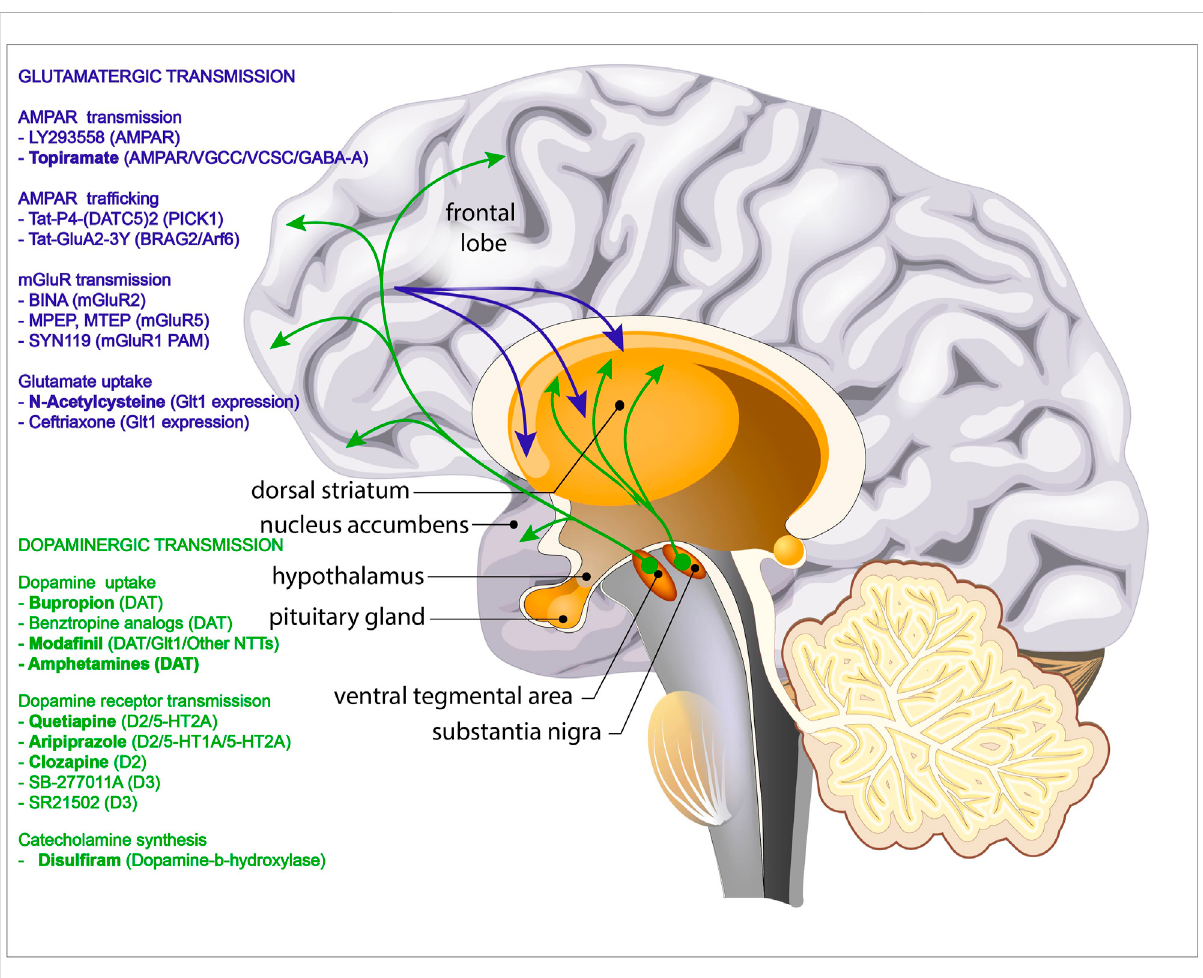
FIGURE 1 Overview of the pathways involved in psychostimulant addiction. Green arrows depict the mesocortical dopaminergic pathways projecting from the ventral tegmental area (VTA) to nucleus accumbens (NAc) and prefrontal cortex (PFC) and the mesolimbic dopaminergic pathways projecting from the substantia nigra to the dorsal striatum. Blue arrows depict the glutamatergic projections from the prefrontal cortex (PFC) into dorsal striatum and nucleus accumbens (NAc). Pharmacological agents that have been shown to reduce addictive behaviour by targeting the dopaminergic transmission are listed in green. Pharmacological agents that have been shown to reduce addictive behaviour by targeting the glutamatergic transmission are listed in green. Drugs that have been tested in human trials are shown in